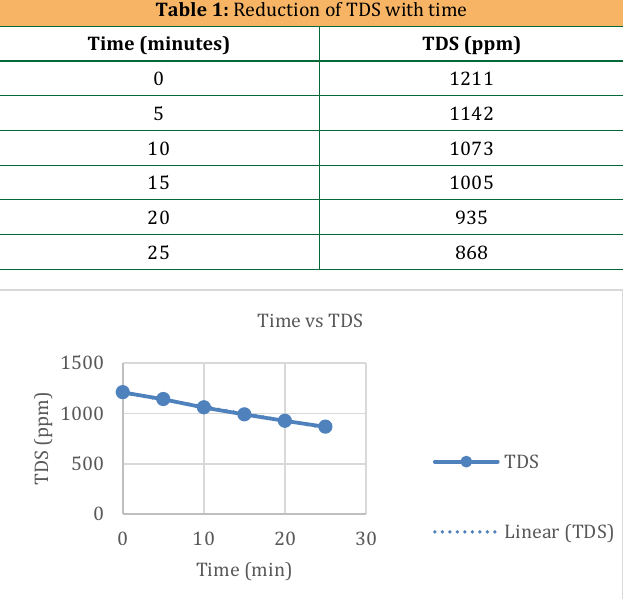
Table 1: Reduction of TDS with time